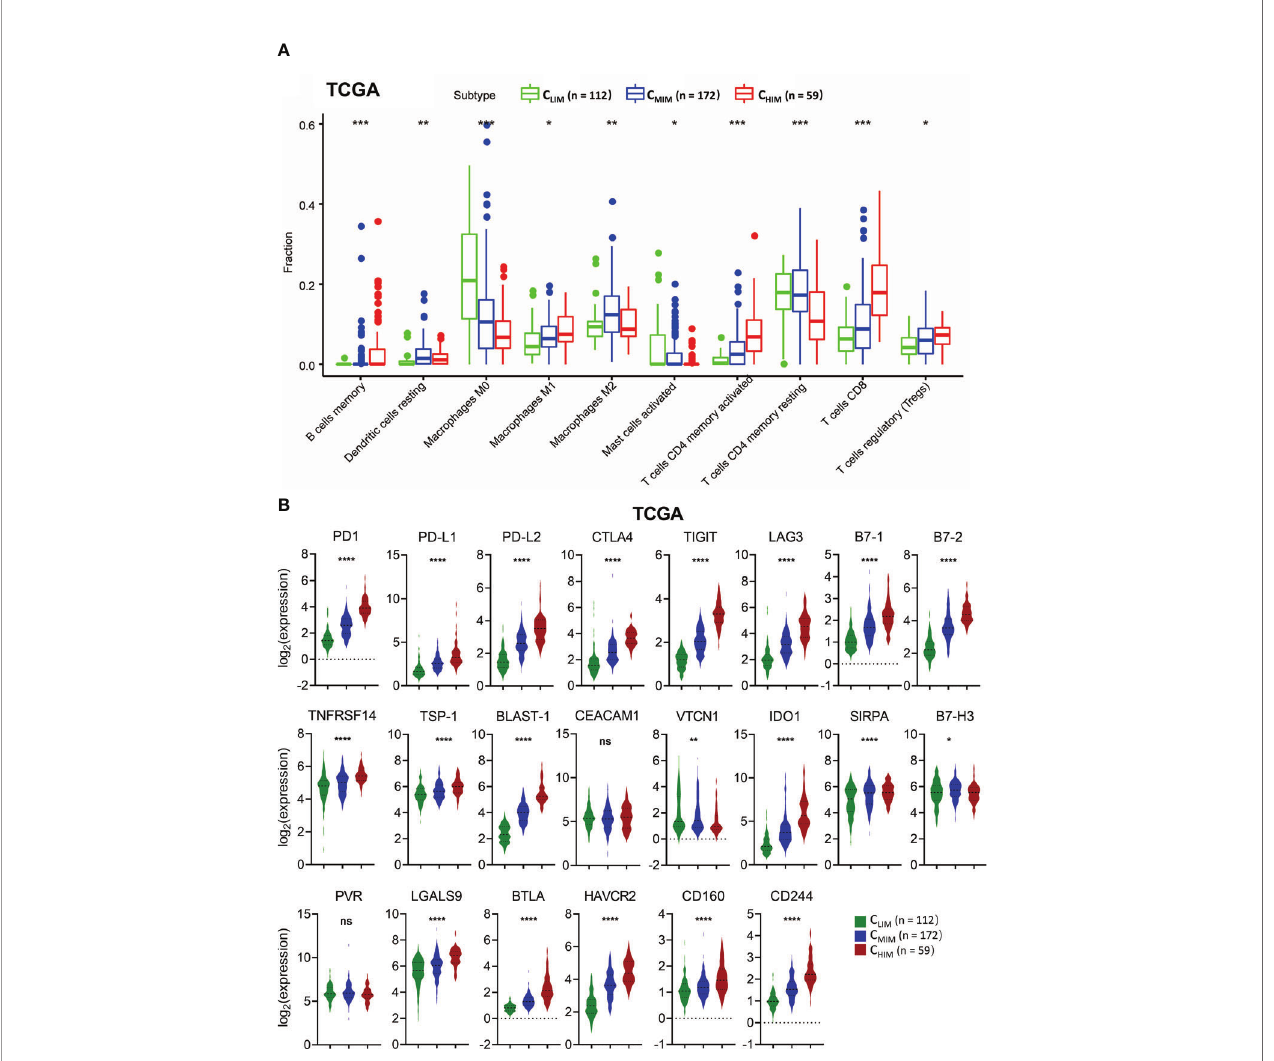
FIGURE 5 | Comparison of immune cell in fi ltration and immune checkpoint molecule levels in different immune subtypes. (A) Fractions of tumor-in fi ltrated immune cells in three immune subtypes in the TCGA cohort. Only cells with signi fi cant differences among the subtypes are shown. (B) Levels of co-inhibitory molecules in three immune subtypes in the TCGA cohort. ns not signi fi cant, * P < 0.05, ** P < 0.01, *** P < 0.001, **** P <